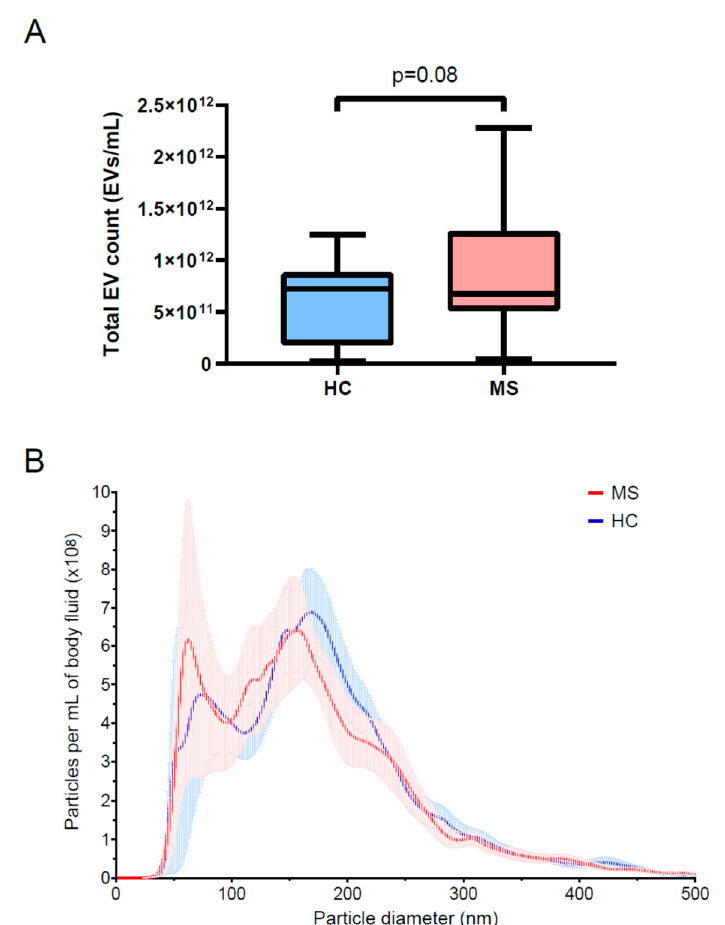
Figure 2. MS and controls do not differ in circulating EV number and size distribution. We compared the concentrations of EVs in serum from MS patients and controls and found no significant difference between the two groups ( A ). We also noted no significant difference in the size distribution of EVs between the two groups ( B ).